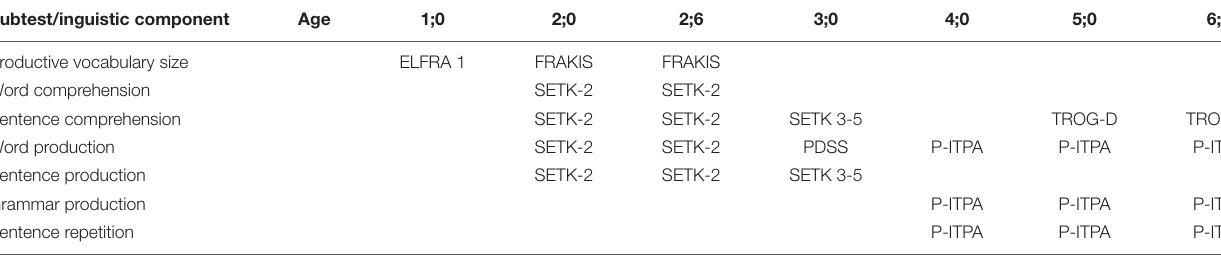
TABLE 2 | Parental reports and standardized tests used to measure language skills.